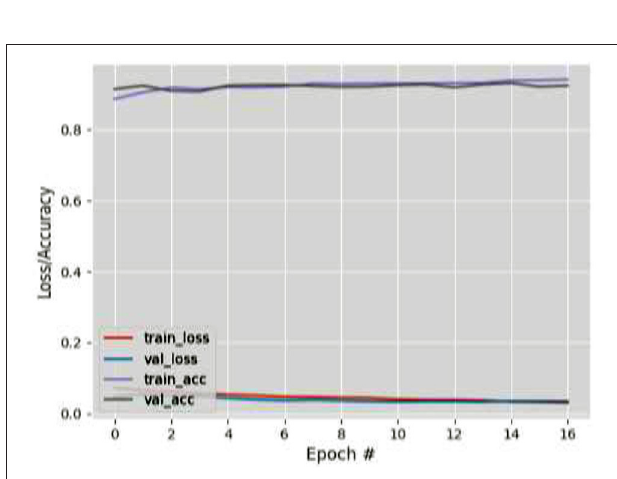
FIGURE 7 | Results for FL + VGG16 on GazeCapture dataset.